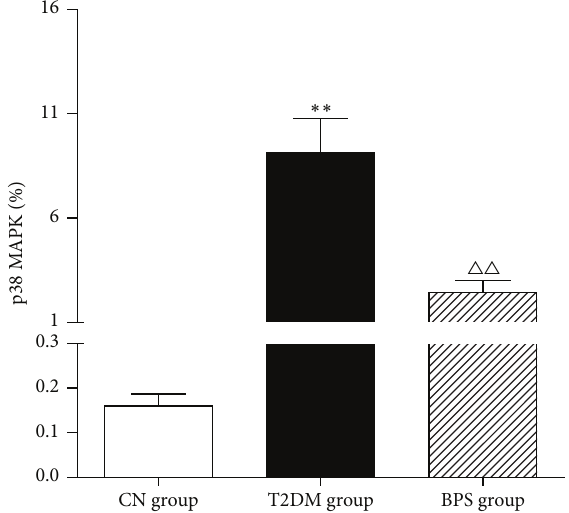
Figure6:Comparisonofp38MAPKmRNAinkidneytissuesofCN group rats, T2DM group rats, and BPS group rats. As bar graph, data are mean ± SD of 6 rats. ∗ 𝑃 < 0.05 and ∗∗ 𝑃 < 0.01 T2DM group and BPS group versus CN group rats and 󳵻 𝑃 < 0.05 and 󳵻󳵻 𝑃 < 0.01 BPS group versus T2DM